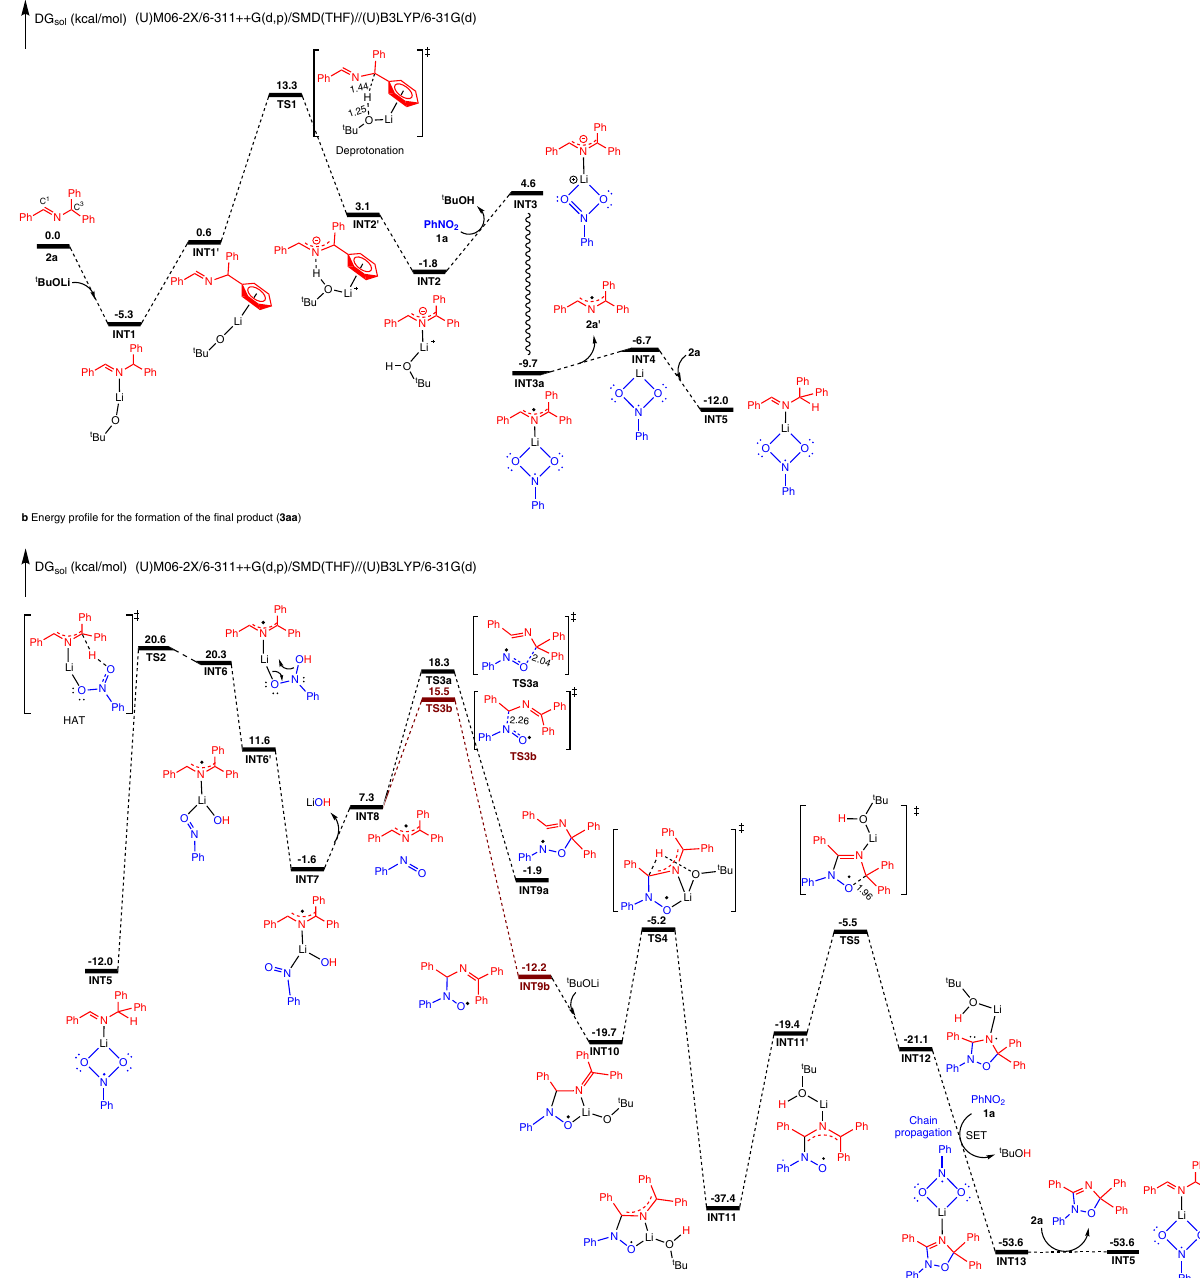
Fig. 8 Computational studies. a Energy pro fi le for the formation of the key 2-azaallyl radical ( 2a ′ ) and nitrosobenzene. b Energy pro fi le for the formation of the fi nal product ( 3aa ). Bond distances are shown in